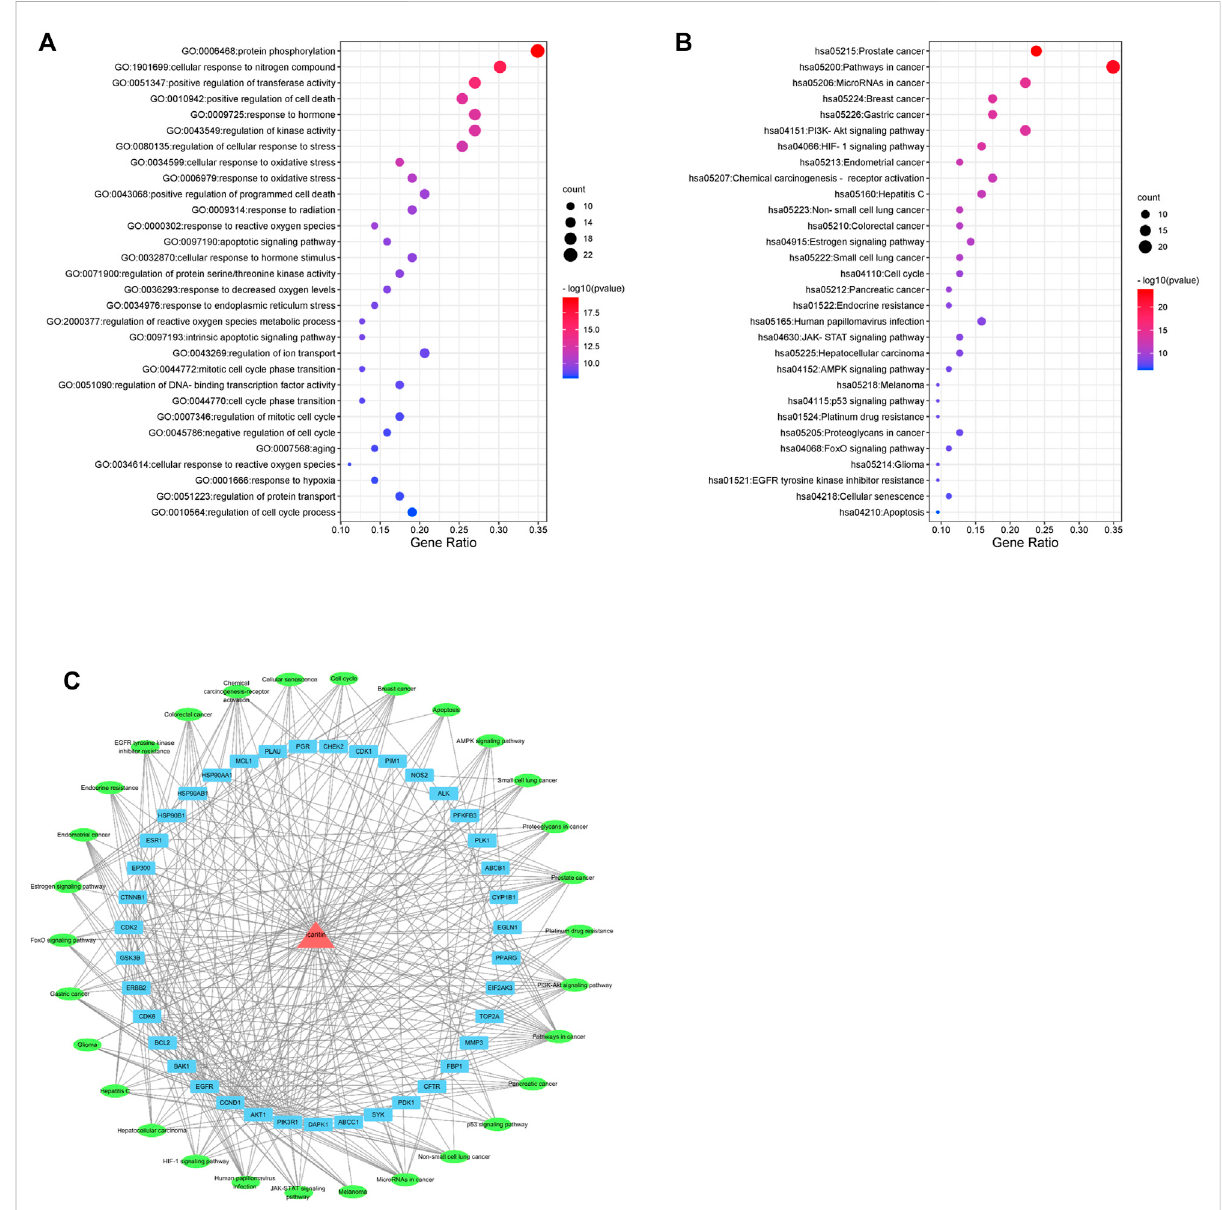
FIGURE 4 Network pharmacology analysis of 30 validated constituents of icaritin. (A) GO enrichment of the key genes in response to icaritin treatment in NPC. (B) KEGG enrichment of potential targets of icaritin in the treatment of NPC. (C) Icaritin-target-pathway network in the anti-tumor effects of